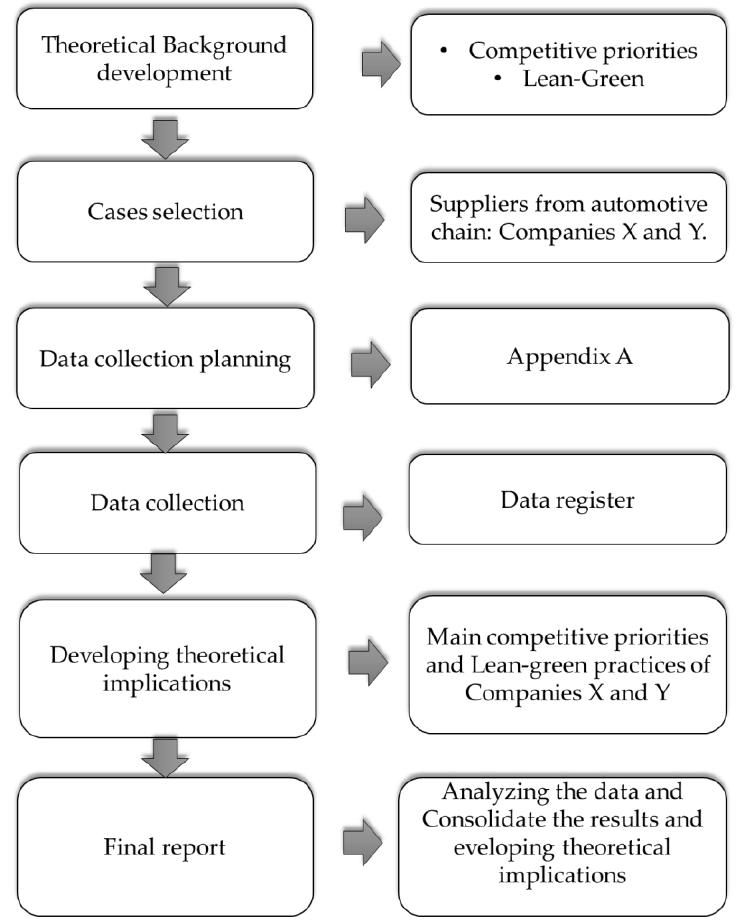
Figure 1. The followed research